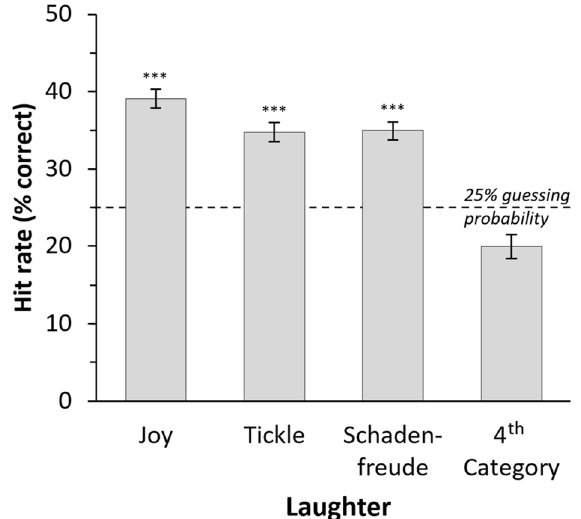
Figure 1. Classification results for Experiment 1. Data combined for all three runs (total N = 159; total number of stimuli = 381). In all runs, Joy, Tickle, and Schadenfreude laughter were presented, plus one additional fourth category (Pity in run 1, Embarrassment in run 2, and Cute-emotion in run 3). Data for the variable fourth category are averaged (see Results for details). ***Hit rate is significantly (p < .001; one-sample t-tests. Bonferroni corrected) higher than the guessing probability of 25% (confirmed by calculation of the unbiased hit rate H u 36 , see Results). Error bars denote standard error of the mean